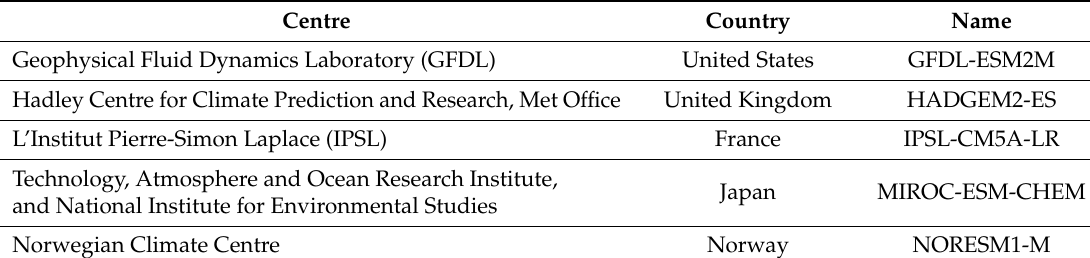
Table 2. List of general circulation models (GCMs) used in this study.